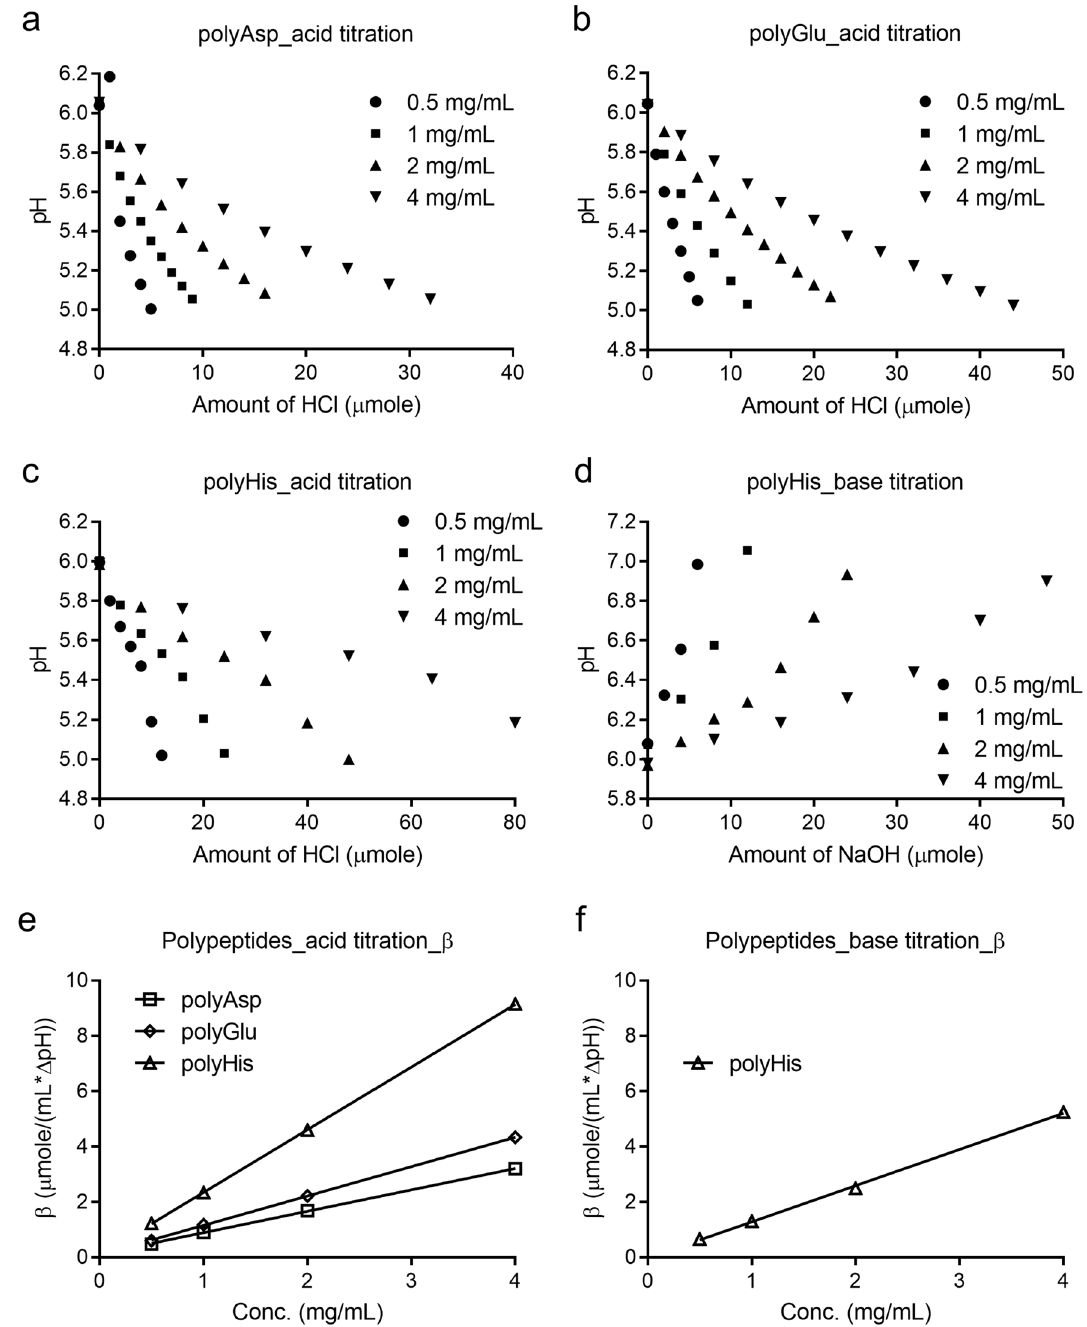
Figure 4. Acid or base titration curves and buffering capacity of polypeptide solutions at different polypeptide